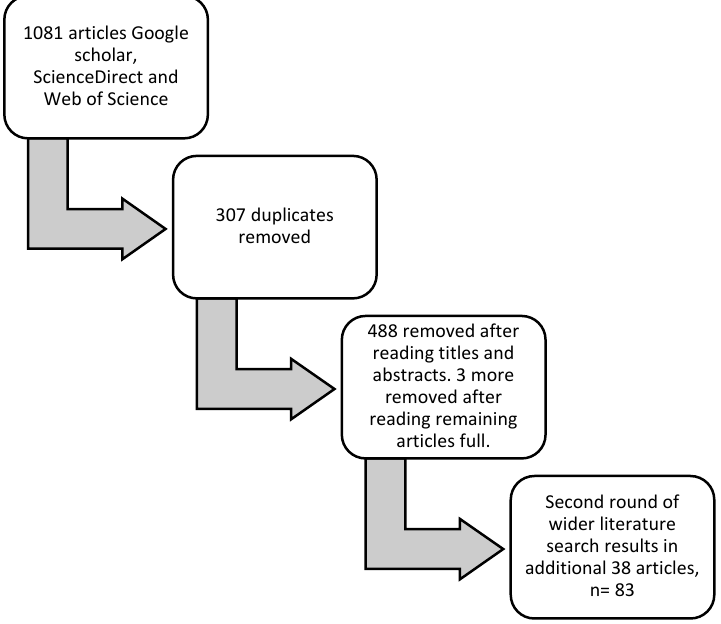
Figure 1. Diagrammatic explanation of review process.